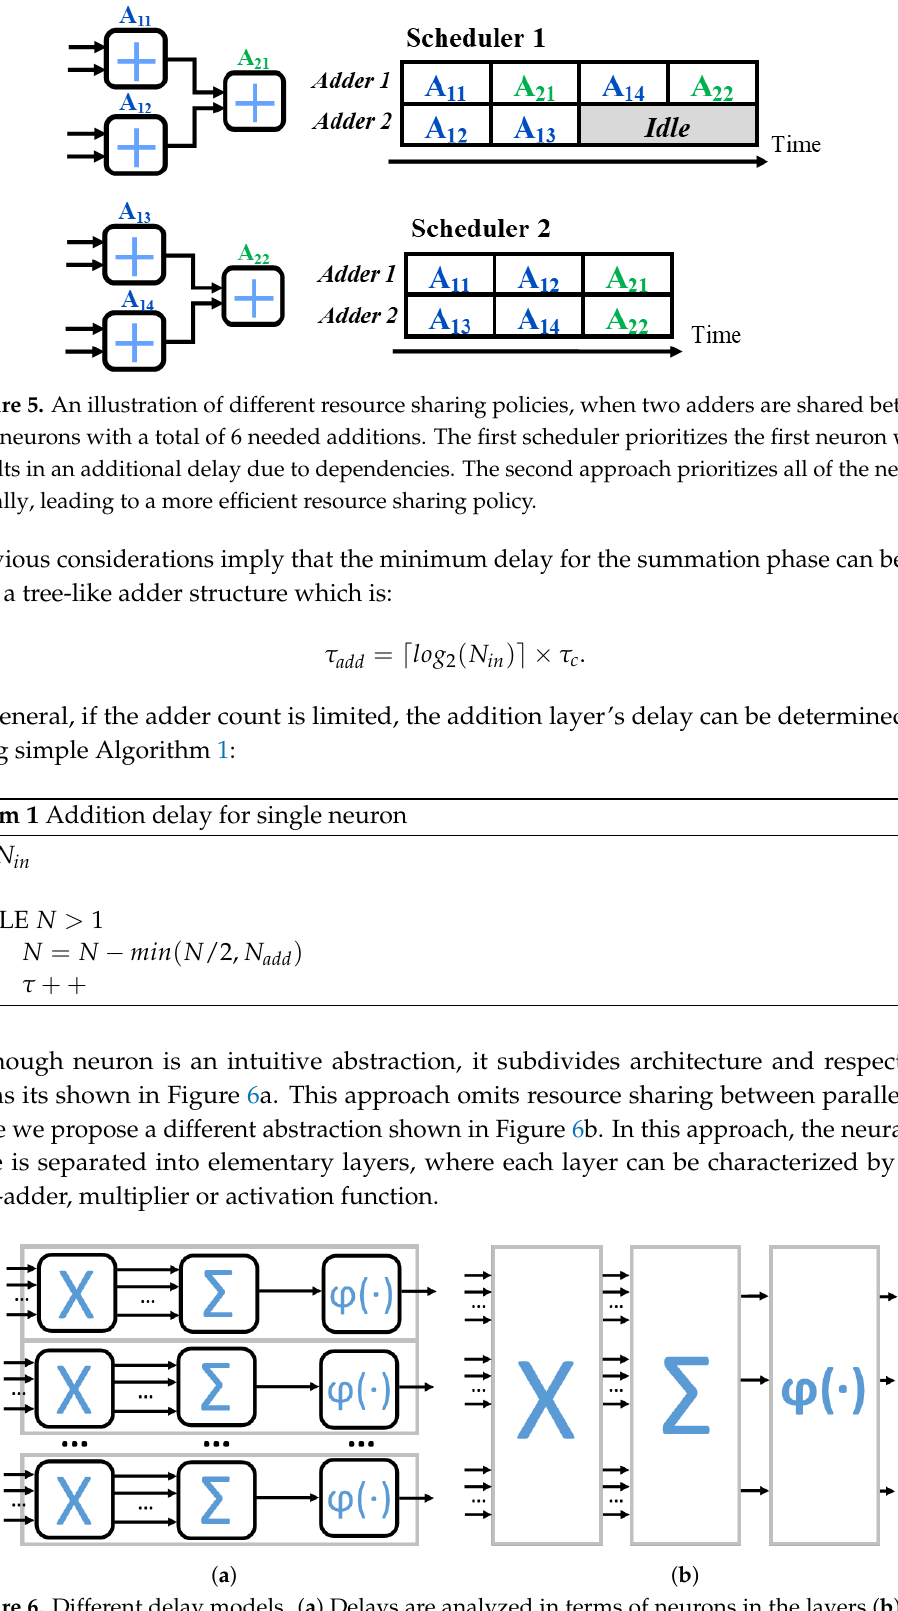
Figure 6. Different delay models. ( a ) Delays are analyzed in terms of neurons in the layers ( b ) Joint delay analysis for “primitive” multiplication, addition and activation layers. ( a ) Conventional delay model for a single layer. ( b ) Proposed delay model with resource sharing for a single